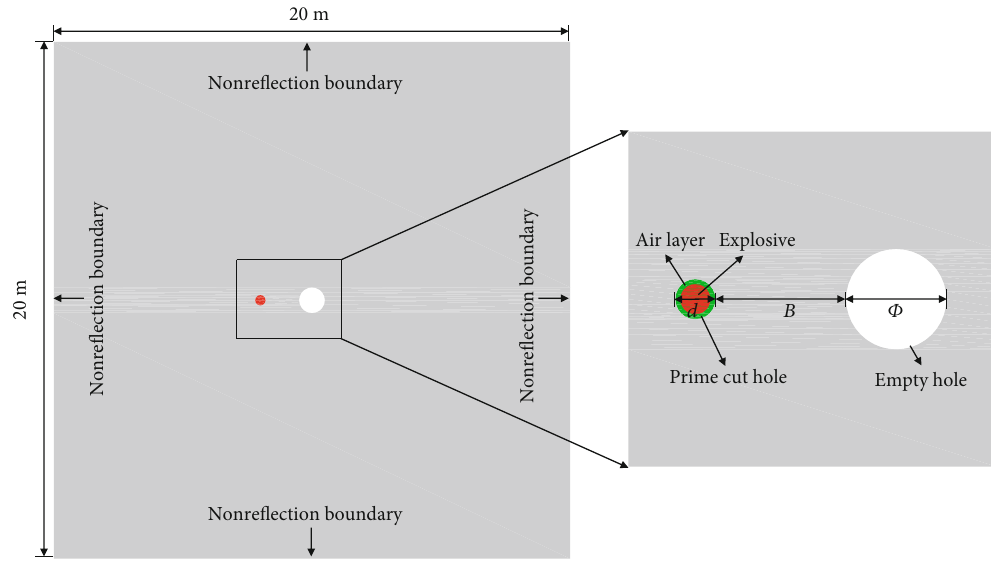
Figure 2: Prime cut blasting numerical model geometry and boundary conditions. Table 3: Numerical simulation